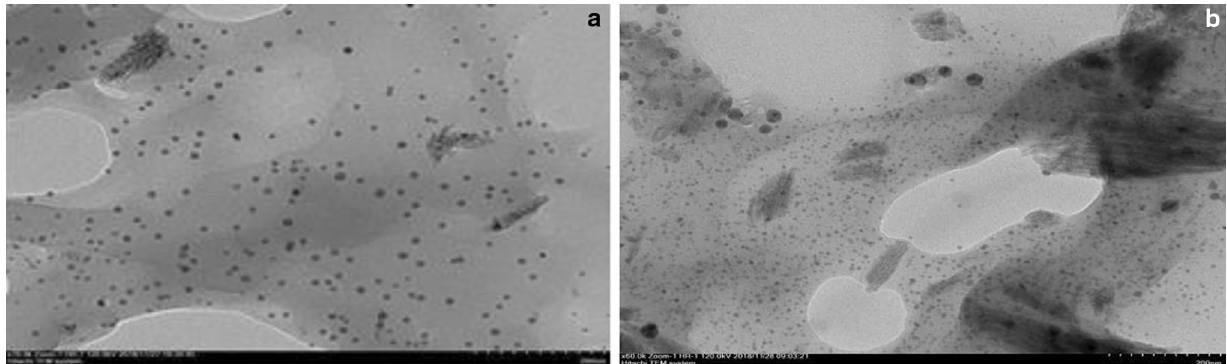
Fig. 7 a shows the TEM analysis of S and CSN b TEM image obtained by the interaction of fenton catalyst CSN and MB